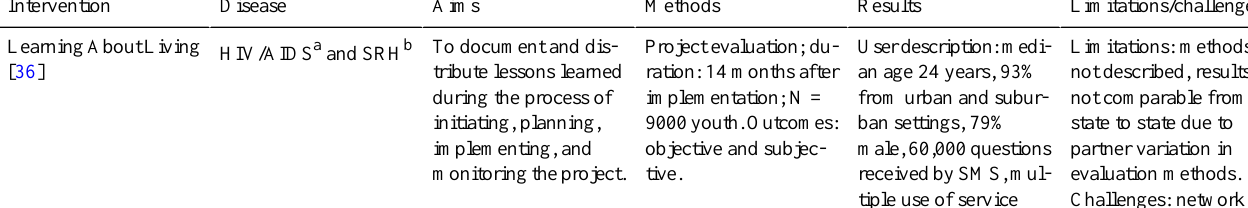
Table 2. Short message service (SMS) interventions for disease prevention with an evaluation